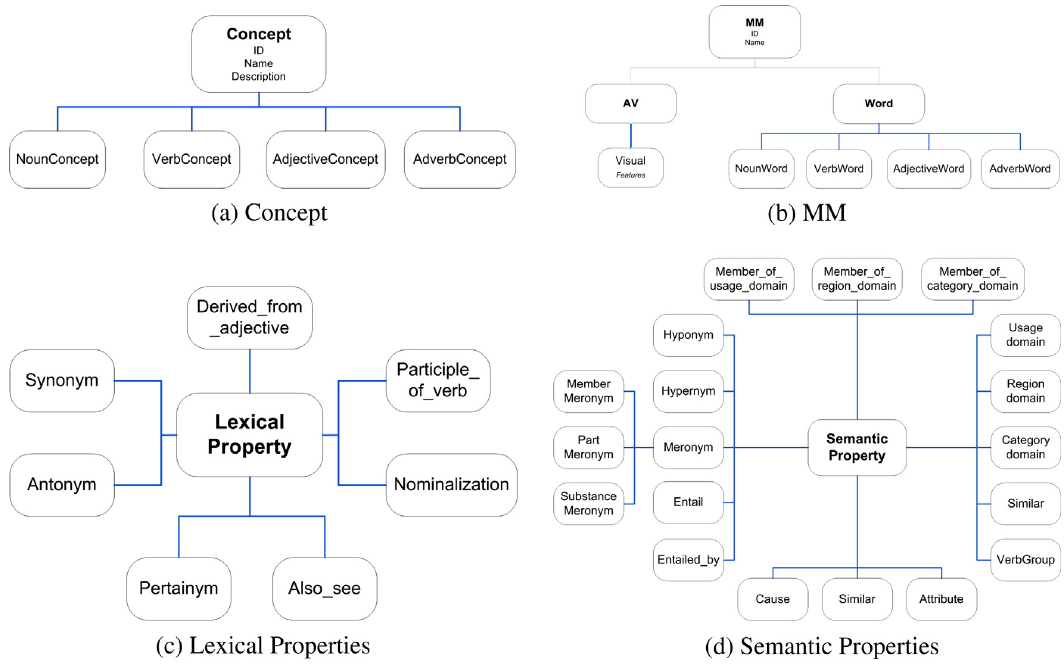
Figure 8. Concept, Multimedia, Semantic